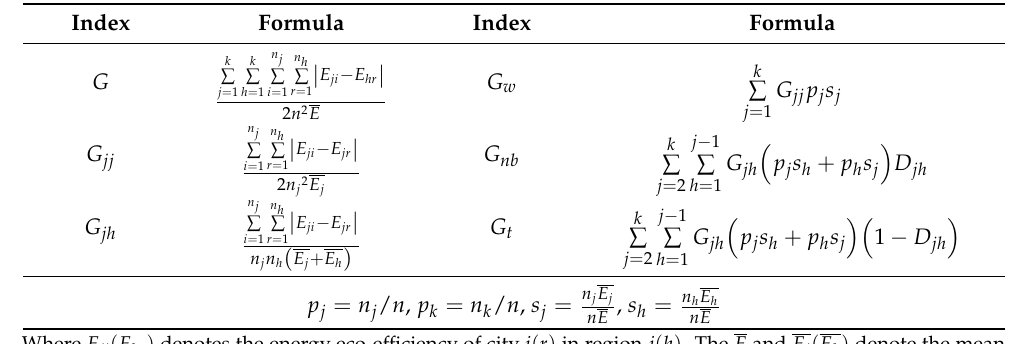
Table 2. Dagum’s Gini coefficient